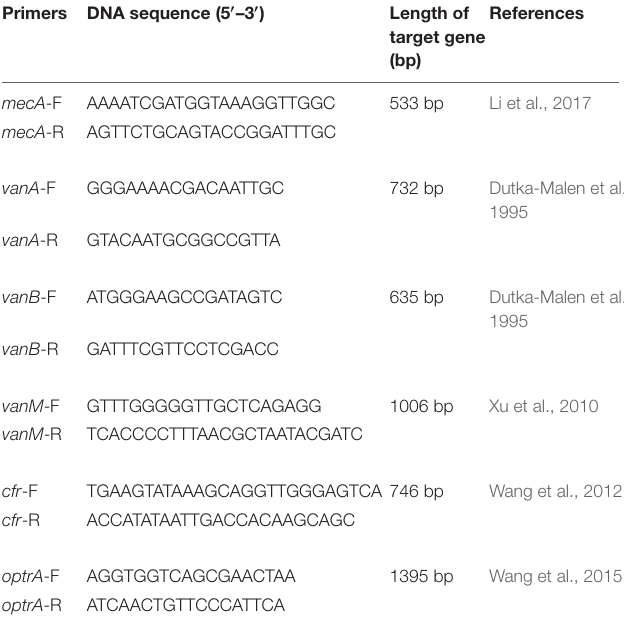
TABLE 1 | Primers used in this